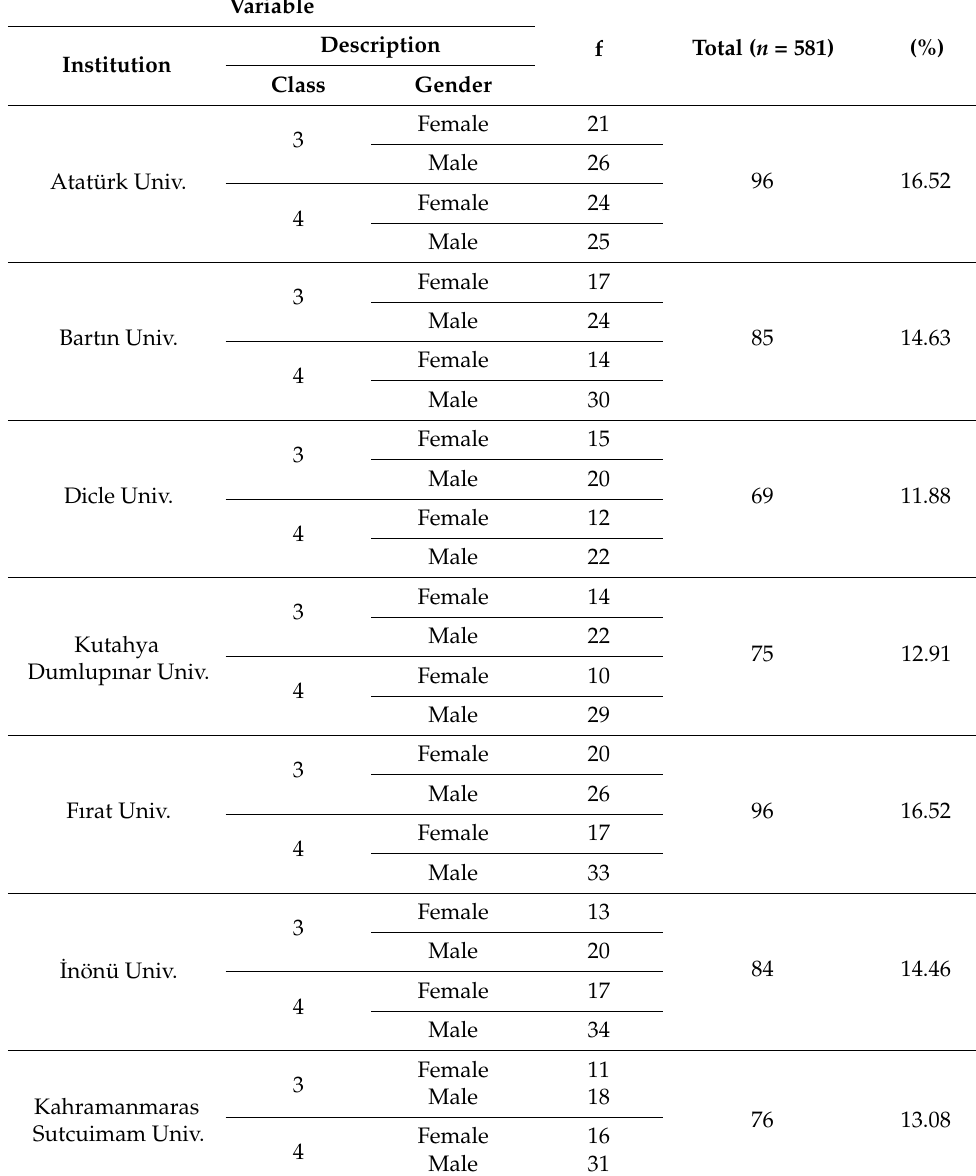
Table 1. Sociodemographic profile of the